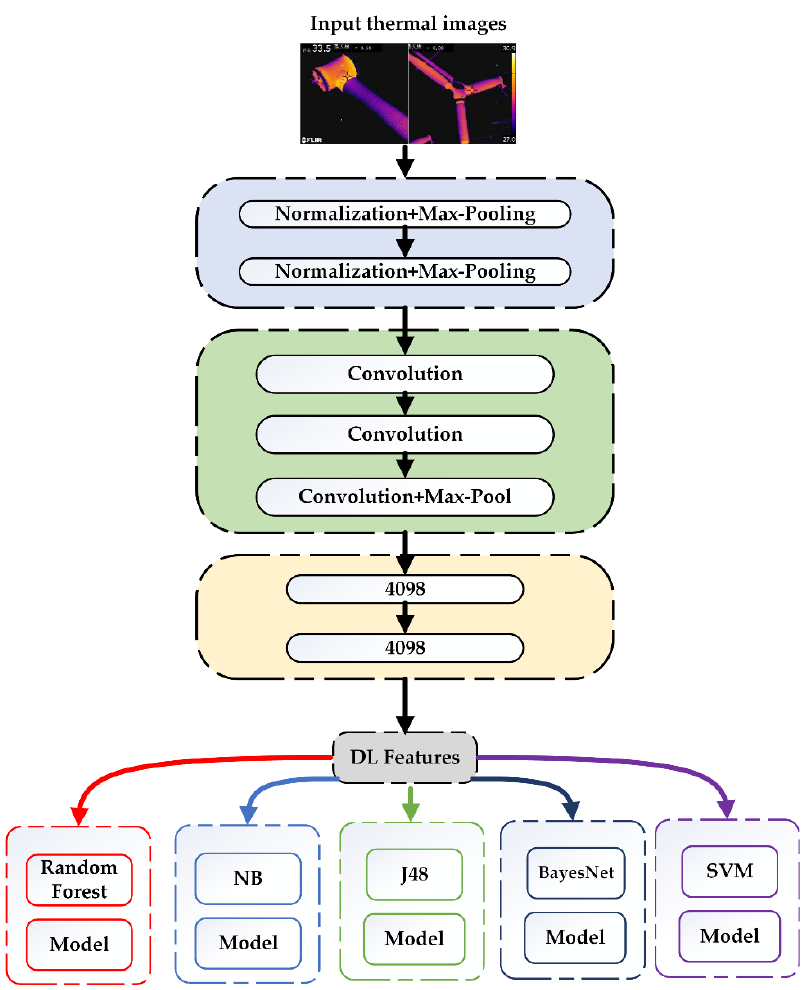
Figure 8. Proposed defective equipment prediction model for high voltage electrical devices. DL: deep learning; NB: naïve Bayes; SVM: support vector machine.